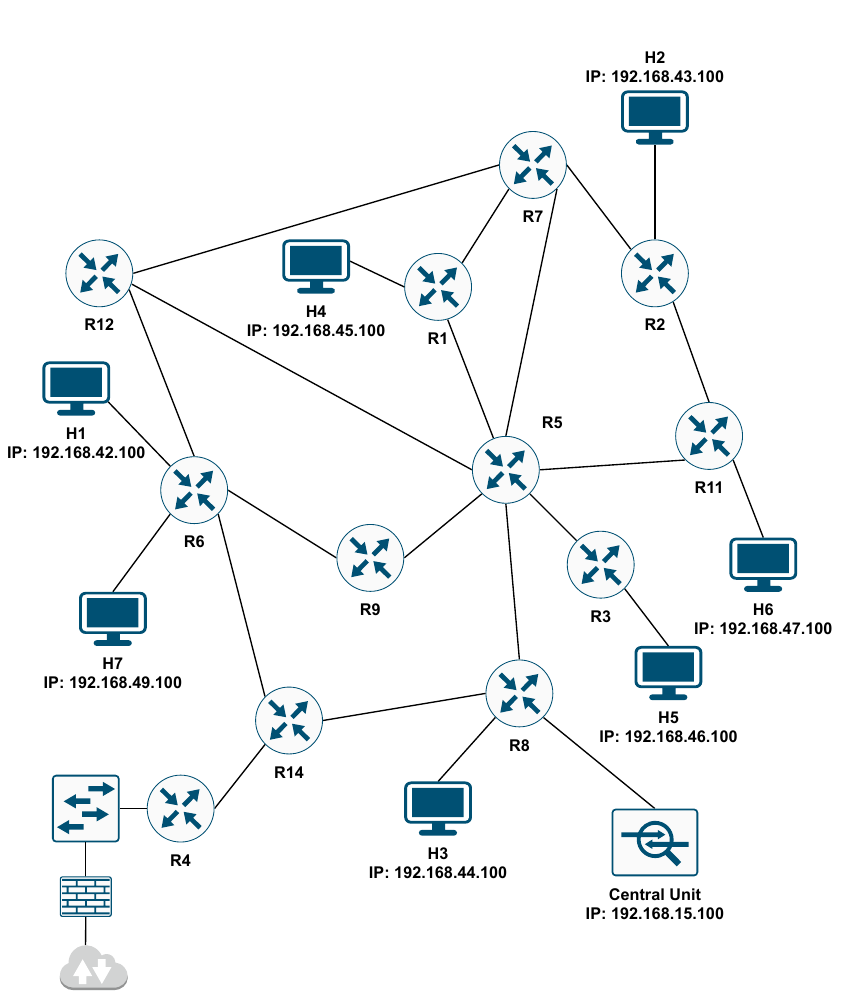
Figure 2. Network setup for simulations of hidden communication